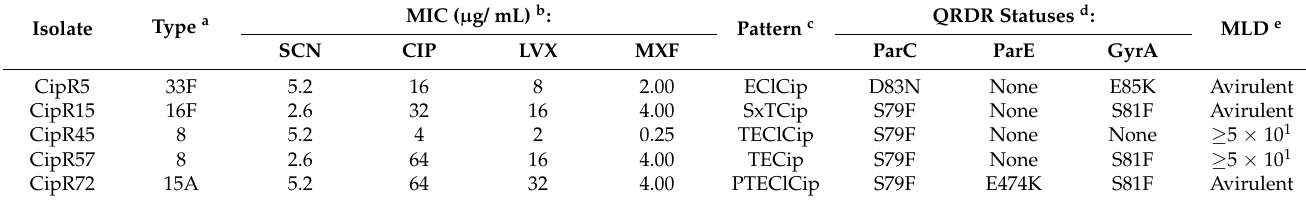
Table 1. Phenotypic and genotypic properties of the isolates used in this